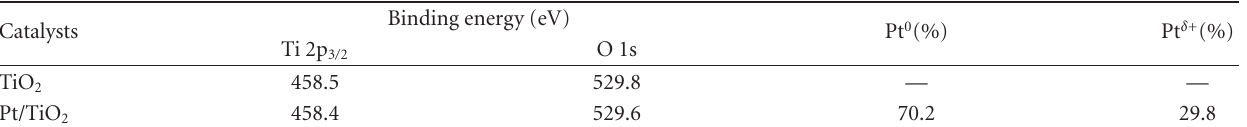
Table 2: XPS results.